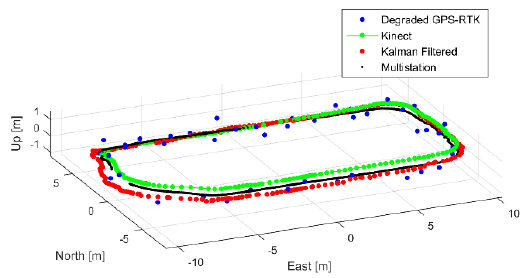
Figure 9. The computed solutions simulating the absence of GNSS signal along the second straight, indicated by the light blue rectangle